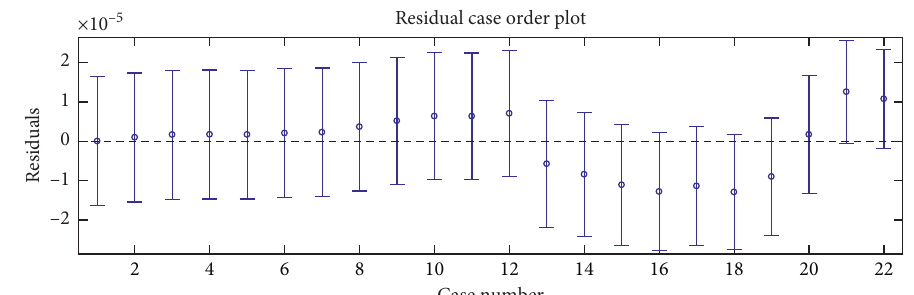
Figure 4: 95% confidence intervals of residuals for infectious proportions.